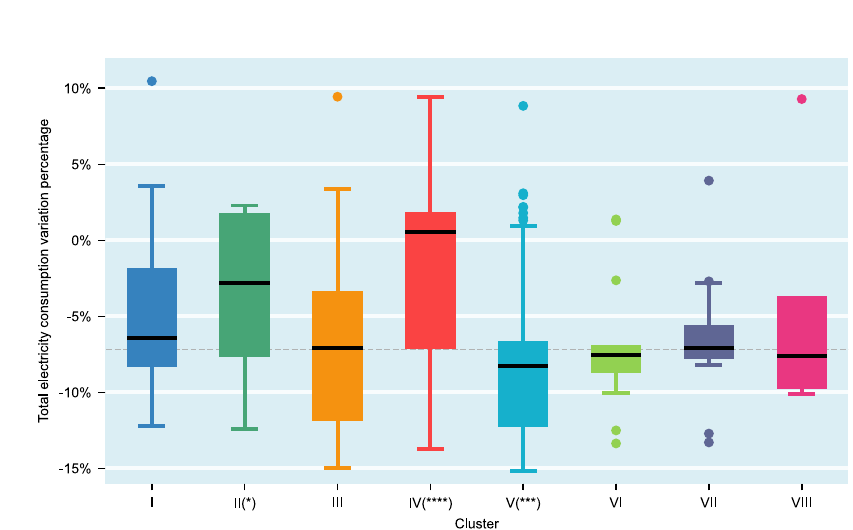
Fig.4|TotalECvariationamongdifferentclusters. Boxandwhiskerplotsoftotal EC variation of April – May 2020 in comparison to pre-pandemic level; boxes depict the upper and lower quartiles of the data; black solid lines depict the median values; whiskers depict the range of the data excluding outliers (outliers are de fi ned as observations larger than 1.5× the inter-quartile range from the upper or lower quar- tiles); the grey dashed line depicts the median value of the total EC variation of 380